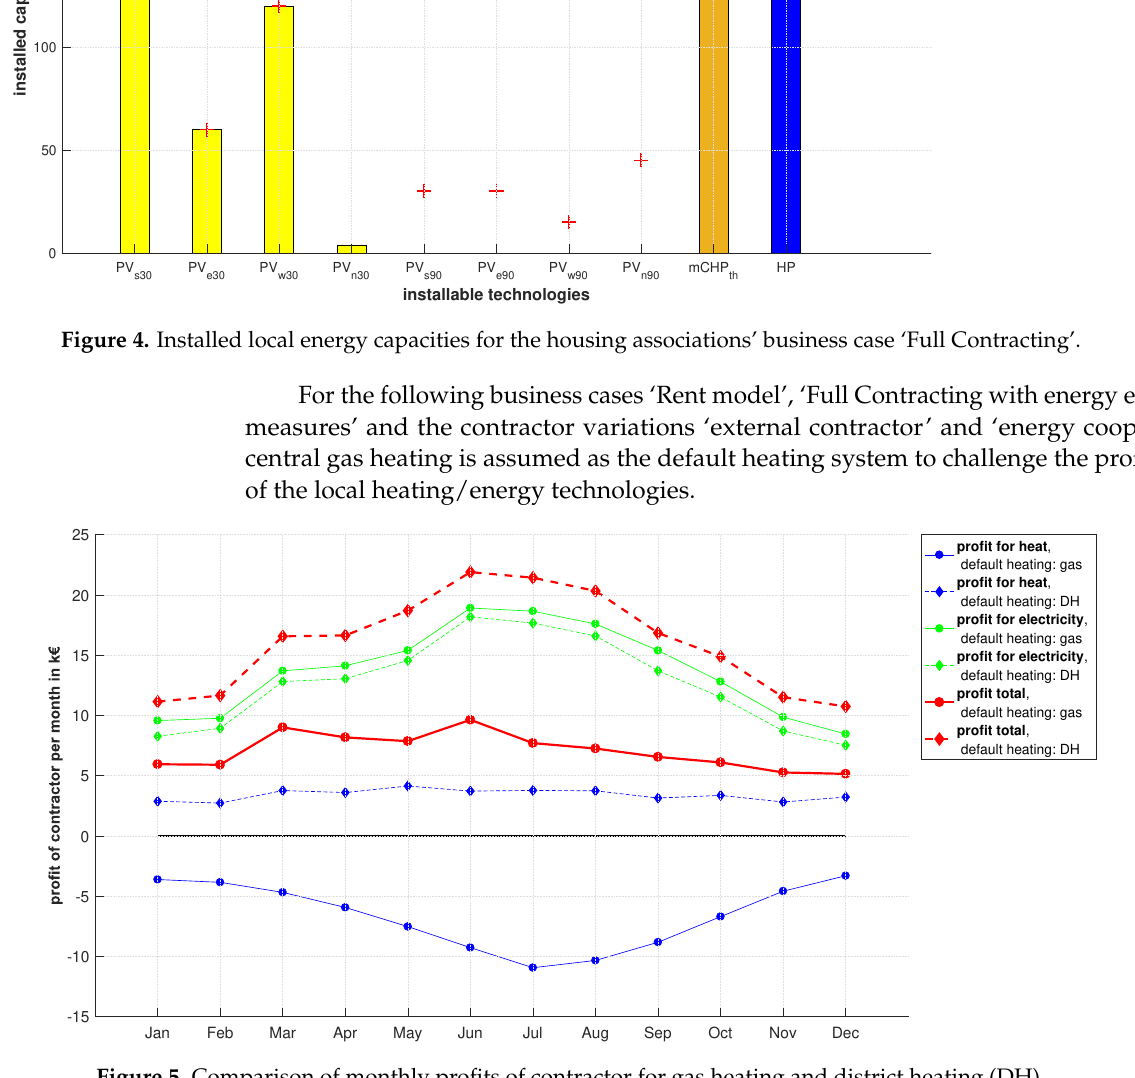
Figure 5. Comparison of monthly profits of contractor for gas heating and district heating